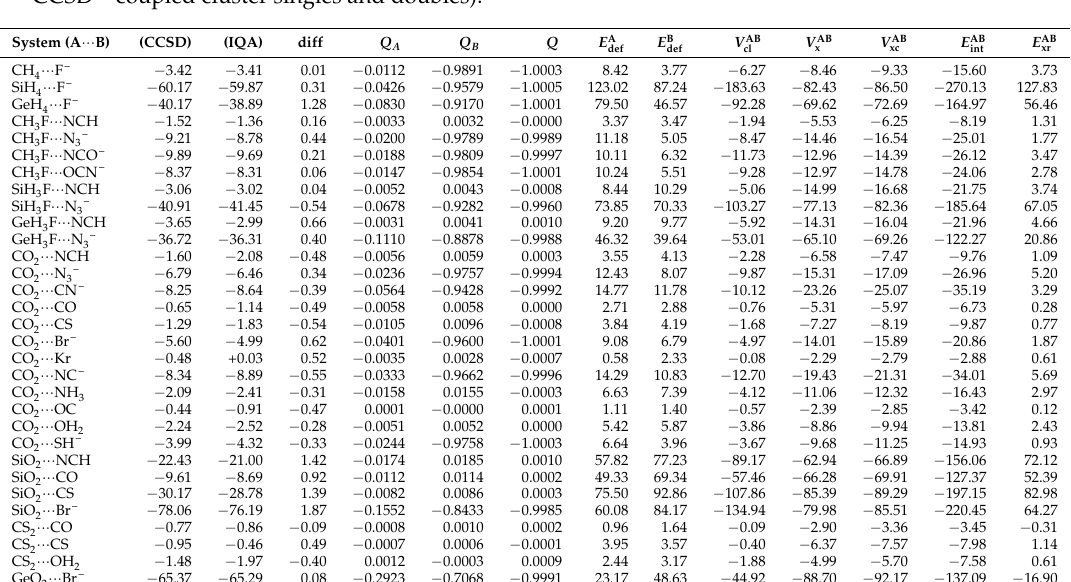
Table 1. Columns 2–7 collect the binding energy obtained from Equations (5), E bind (CCSD) ≡ (CCSD), and (8), E bind (IQA) ≡ (IQA), its difference (diff = E bind (IQA) − E bind (CCSD)), and the total interacting quantum atom (IQA) integrated charges, Q A , Q B , and Q = Q A + Q B Columns 8–14 show the different contributions to E bind (IQA), according to Equations (8)–(11). Energy units in (Kcal/mol); CCSD—coupled cluster singles and